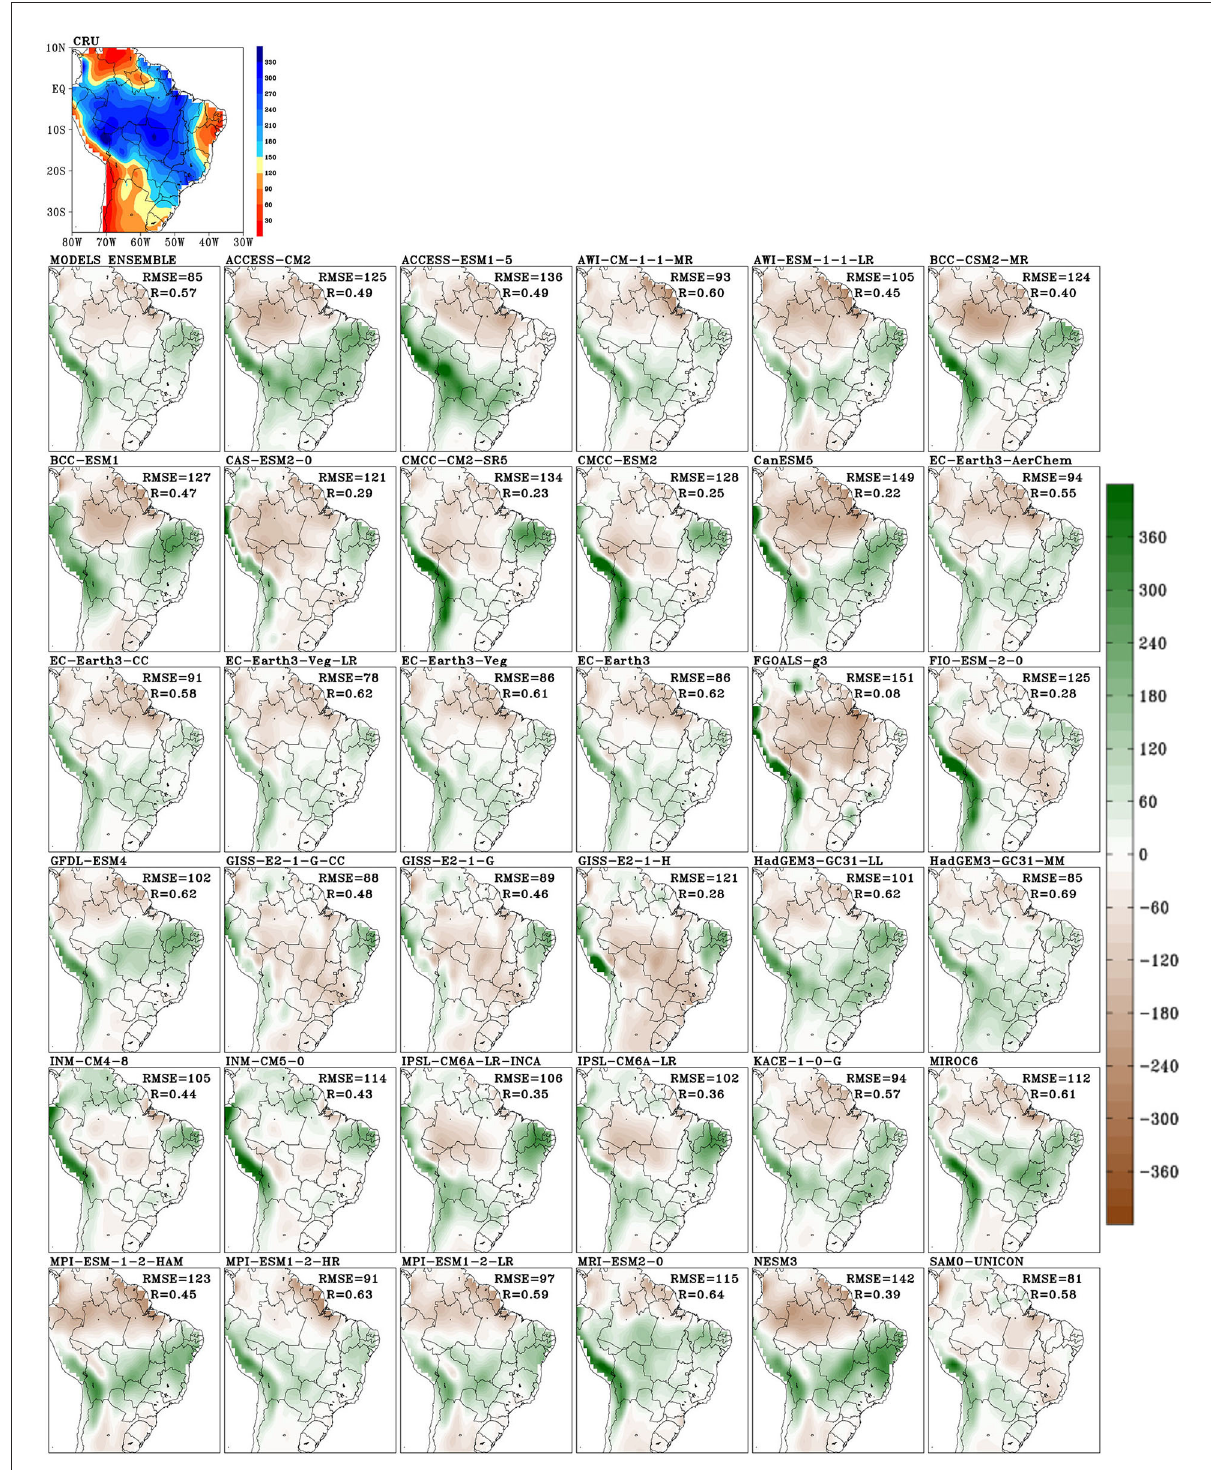
FIGURE6 CMIP6 model biases and CRU-observation (top left panel) for precipitation: Austral summer (DJF). Unit: mm/month.